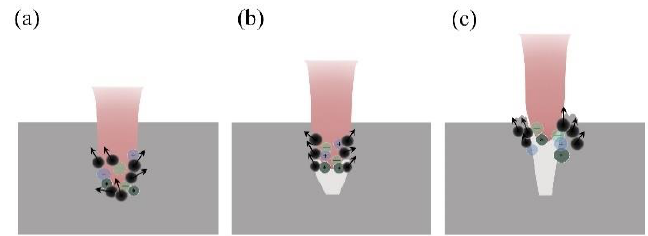
Figure 12. The diagram of the evolution mechanism of trapezoidal groove structure: ( a ) processing of bottom of trapezoidal groove, ( b ) upward movement of focus and ( c ) processing of top of trapezoidal groove.